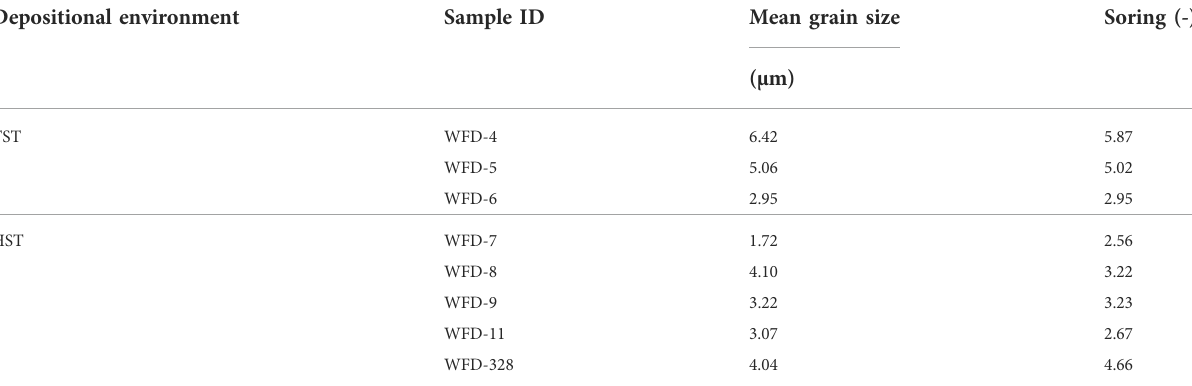
Depositional environment